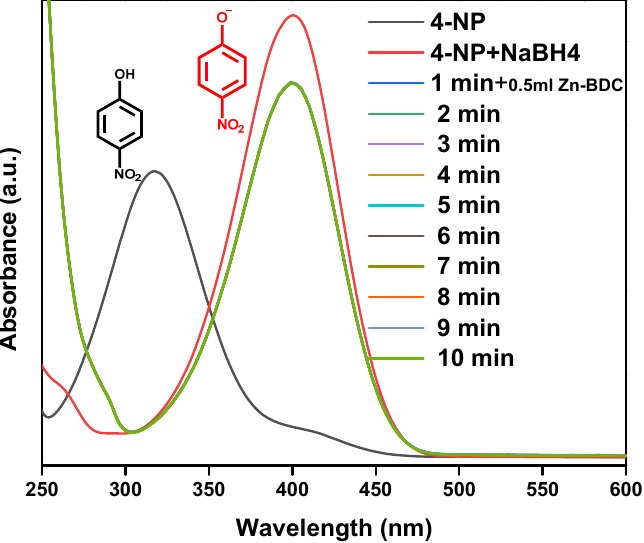
Figure 9. UV ‐ Vis spectra of the catalytic reduction of 4 ‐ NP to 4 ‐ AP using 0.5 mg of (Zn ‐ BDC). Assuming a pseudo ‐ first ‐ order reaction, the following equation was considered to evaluate the kinetic parameters.